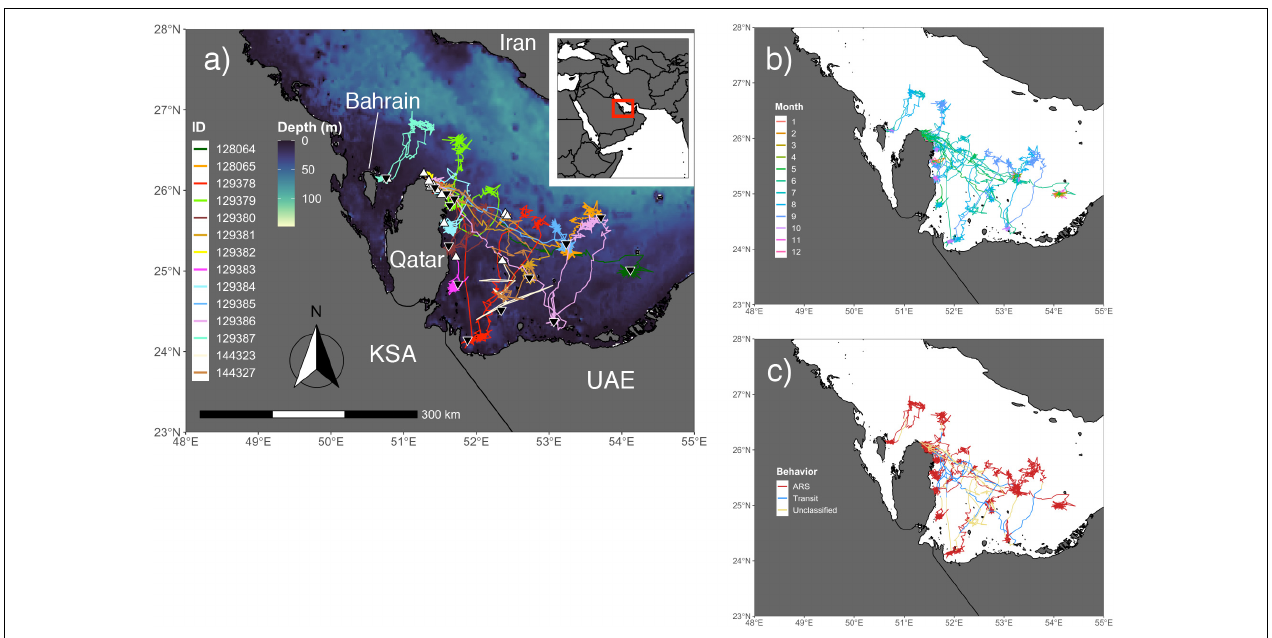
FIGURE 1 | Output from the behavior-switching state-space models (SSSMs) for hawksbills within the Arabian Gulf. (a) Study area for tagging and movements of hawksbill turtles with bathymetry shown (GEBCO_2014; 30 arc-second). White triangles denote the tagging location and black upside down triangles indicate the location of final transmission. (b) Colors of hawksbill relocations display the monthly pattern of turtle movement throughout the region. (c) Area-restricted search (ARS), transit, and unclassified latent behavioral states from the SSSMs are displayed for each relocation, showing the migration corridors and regions of intense use by these